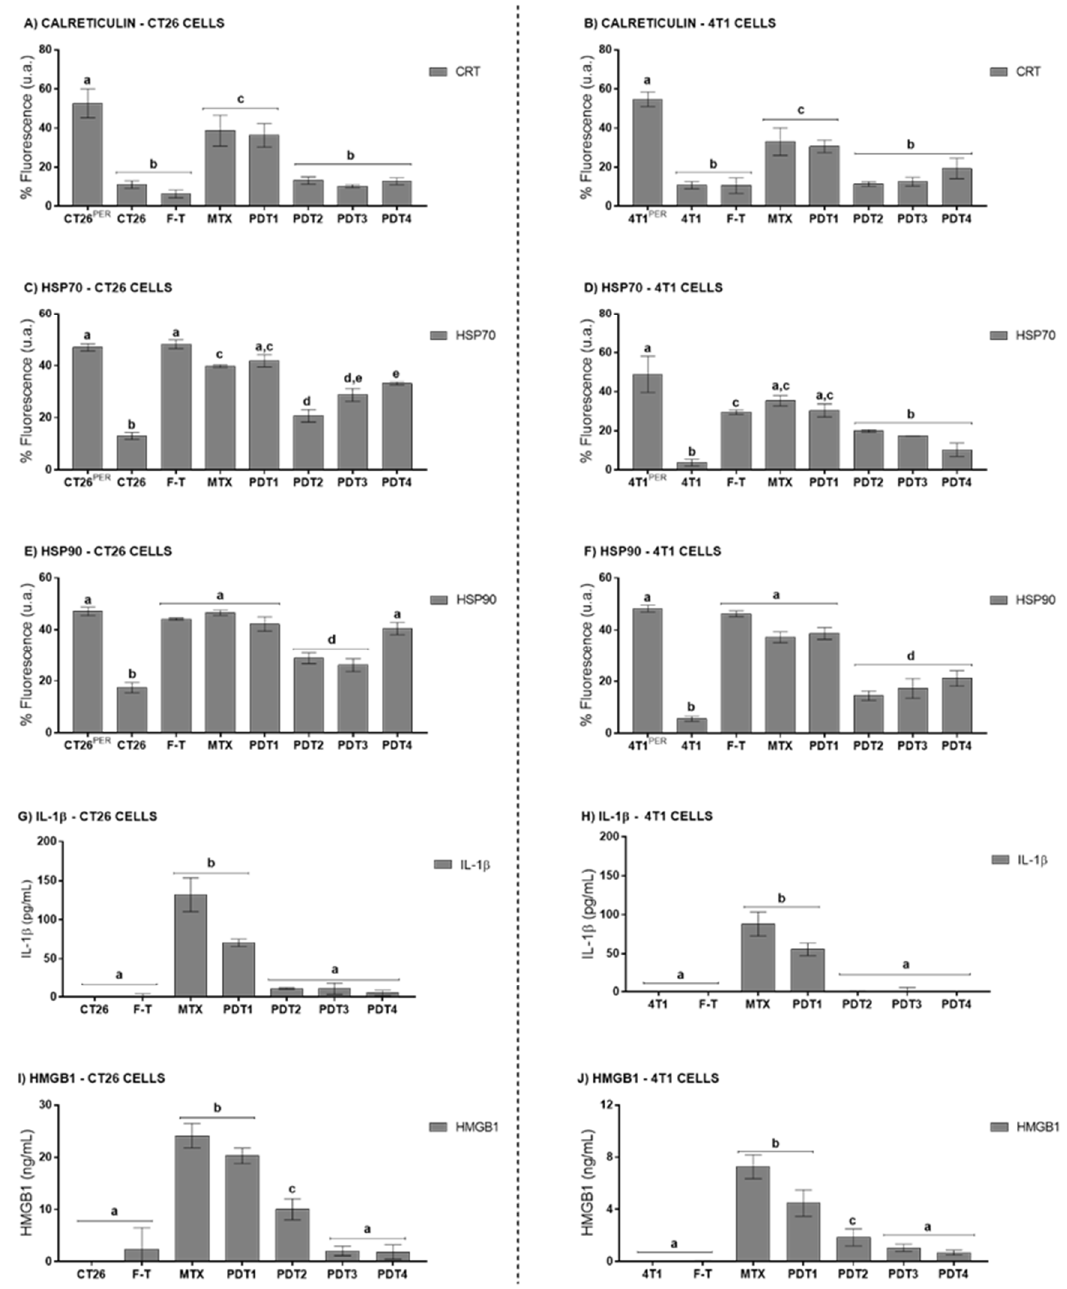
Figure 2. PDT-AlPc-NE induces the release of DAMPs by murine colorectal carcinoma (CT26) and murine mammary adenocarcinoma (4T1) cells. Surface CRT ( A , B ), surface HSP70 ( C , D ), and surface HSP90 ( E , F ). Supernatant IL-1 β ( G , H ) and HMGB1 ( I , J ) letters refer to CT26 and 4T1 cells, respectively. Untreated cells are representing with CT26 and 4T1.PDT protocols for CT26 cells: PDT1 = 12.2 nM and 25 J/cm 2 ; PDT2 = 31.5 nM and 25 J/cm 2 ; PDT3 = 12.2 nM and 67 J/cm 2 ; and PDT4 = 31.5 nM and 67 J/cm 2 . PDT protocols for 4T1 cells: PDT1 = 9.01 nM and 25 J/cm 2 ; PDT2 = 19.4 nM and 25 J/cm 2 ; PDT3 = 9.01 nM and 67 J/cm 2 ; and PDT4 = 19.4 nM and 67 J/cm 2 . MTX: mitoxantrone; F-T: three cycles of freeze-thawing. Superscripts PER mean the cells submitted to permeation with Triton X-100 0.1%. Equal letters represent results without significant differences between groups. Data are presented as mean ± SEM for